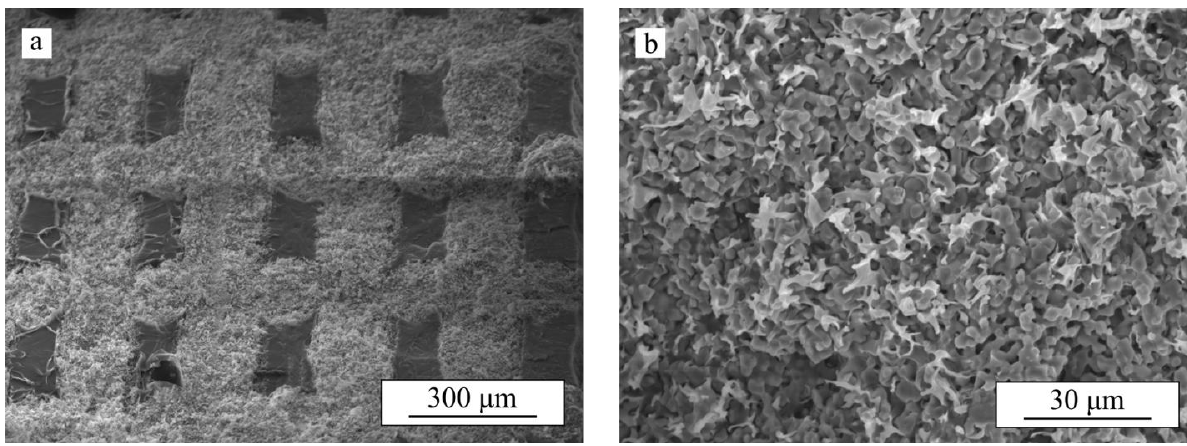
Figure 10. SEM micrographs of a TCP/PLA specimen after bending test: ( a ) fracture surface at low magnification; and ( b ) detail of fracture surface within a rod. Short microfibrils but no macrofibrils are